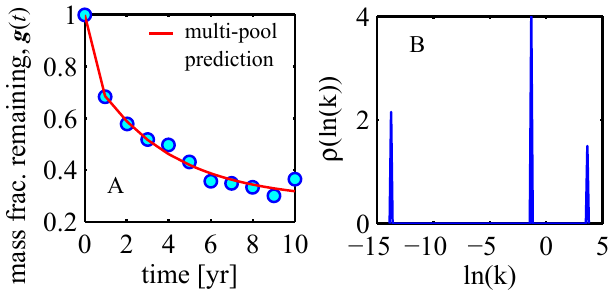
Fig. 1. Inverse Laplace transform of a LIDET dataset. (A) Decay data g indicating the mass fraction remaining of a single litter type at one location in the LIDET study. In this case, the litter is a leaf of the species Drypetes Glauca decaying at Alaska’s Arctic Lakes. Line is the fit to the data corresponding to the distribution ρ( ln k) shown in (B) . (B) Distribution ρ( ln k) obtained by numerical inversion of the data ˆ g using the constrained non-negative least squares